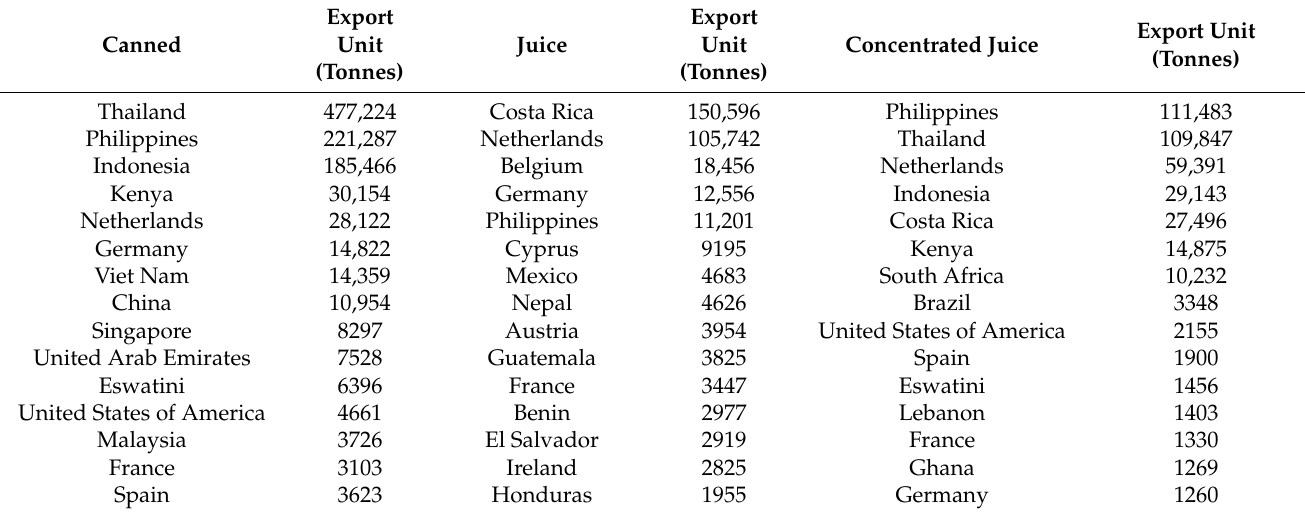
Table 1. Main exporting countries of processed pineapple products under the form of canned, juice and concentrated juice in 2018 (data extracted and modified from FAO